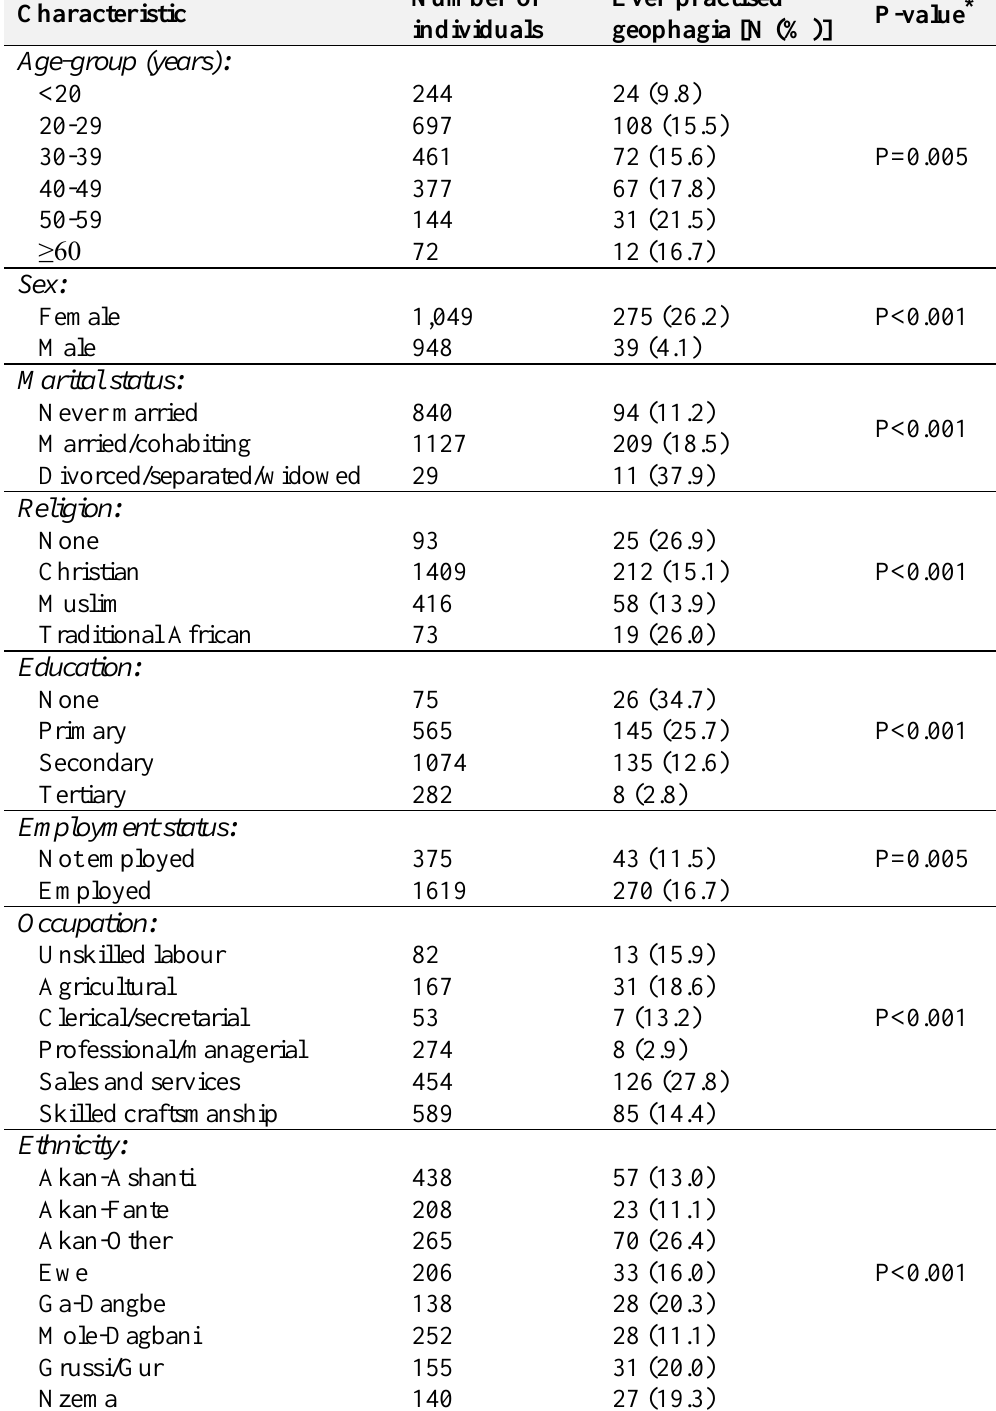
Table 1. Background of respondents and the practice of Geophagia Number Characteristic